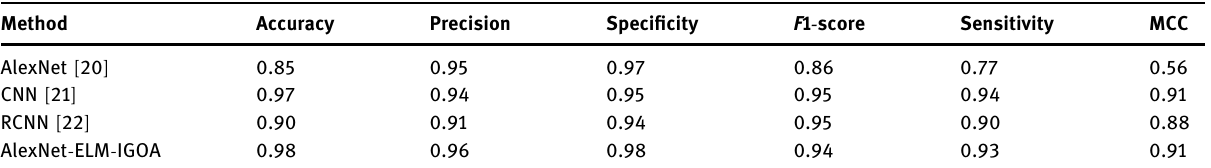
Table 3: The performance analysis of the proposed method toward some other state of the art methods Method